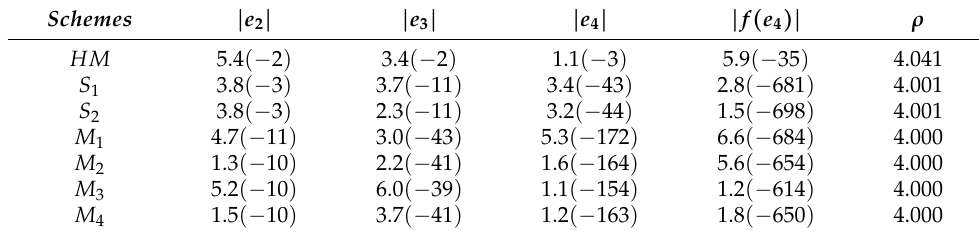
Table 3. Numerical results of function f 3 .